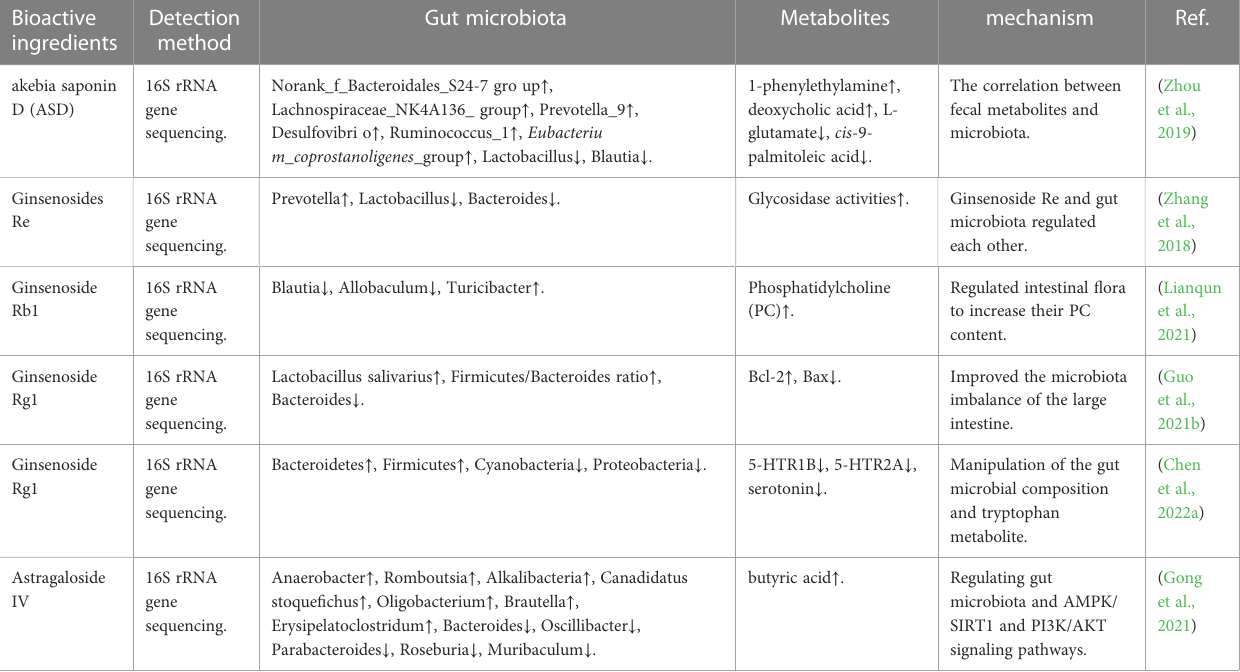
TABLE 2 The saponins from TCM regulated gut microbiome.